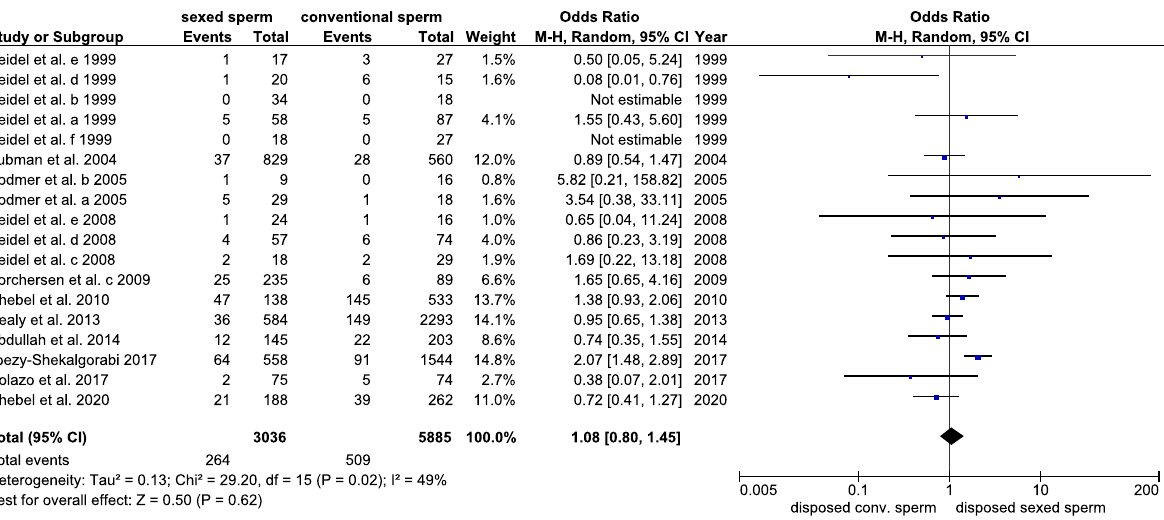
Figure 7. Forest plot of the abortion rates after the use of sex-sorted sperm compared to conventional